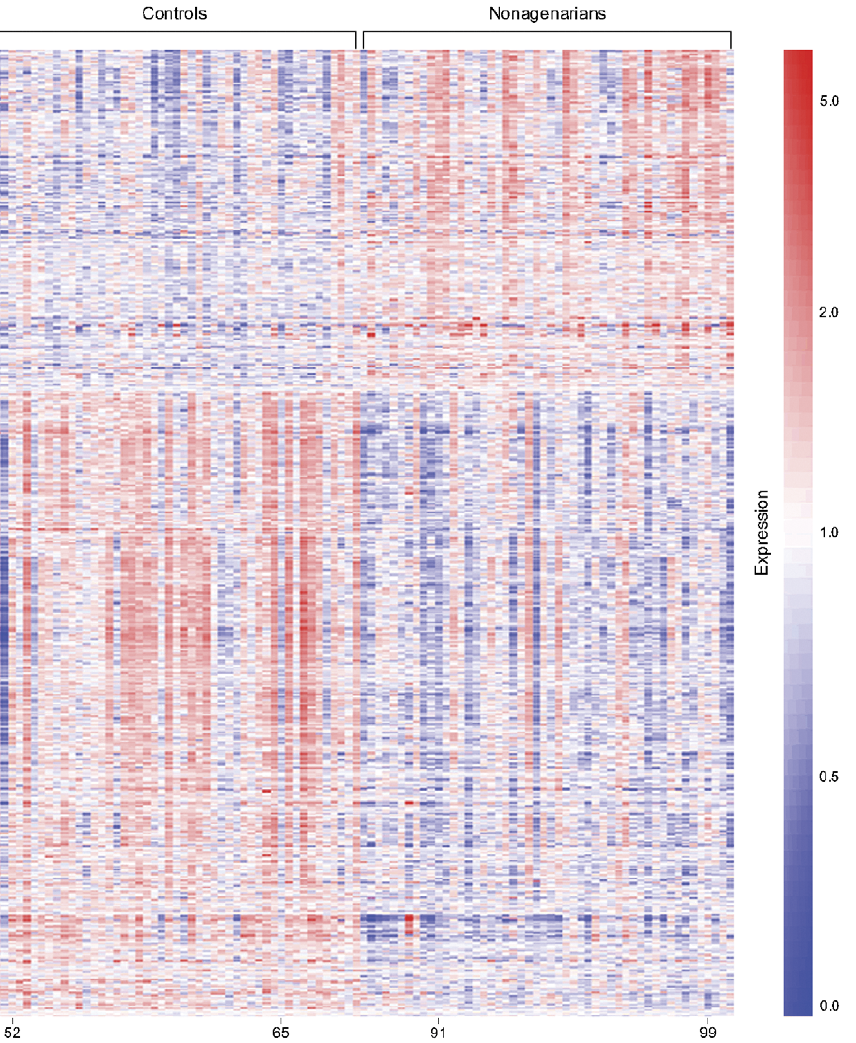
Figure 2. Expression profiles of 2,953 probes that differed between nonagenarians and middle-aged controls. Expression intensities of the 2,953 probes were analyzed by one-dimensional hierarchical clustering. Each probe is represented by a row; each subject by a column. Samples are organized left to right by increasing age which is indicated for a few individuals for reference. The largest cluster of probes exhibits reduced expression (transition from red to blue), and another cluster exhibits increased expression (transition from blue to red) in nonagenarians compared to controls. Mean centered expression values of probes are displayed according to the color scale in which red represents above average expression levels and blue below average expression levels. Fold changes of individual probes are given in Supplementary Table